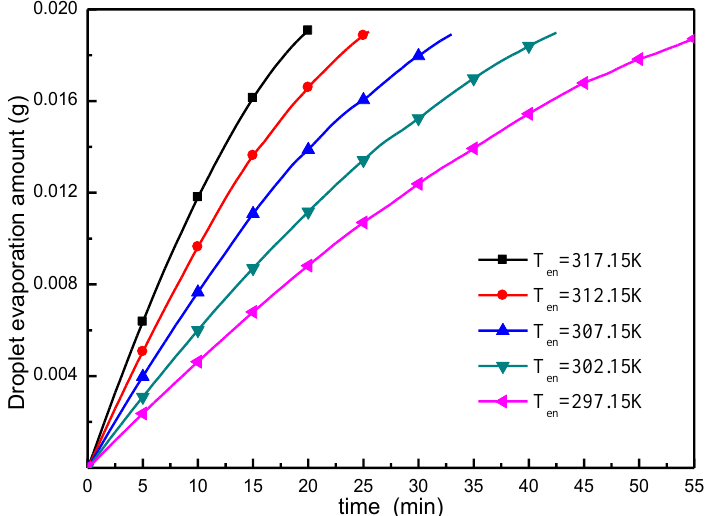
approximately 22.7%.